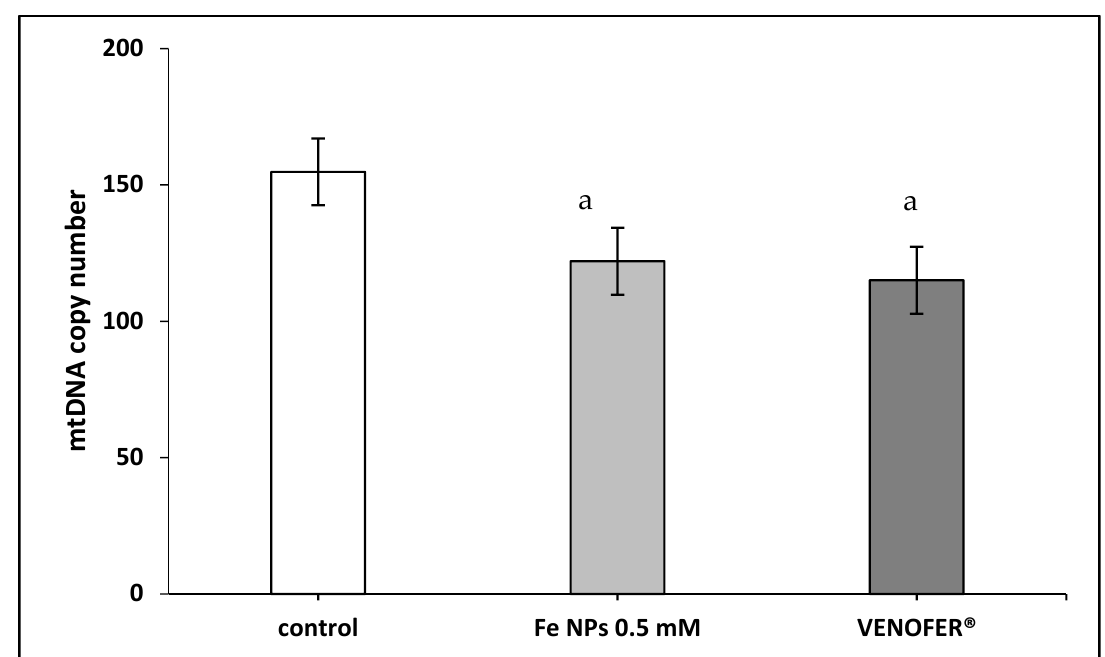
Figure 2. ND1/ND4 mtDNA deletion. Results expressed as mean ± SEM. ( p < 0.05). (a) vs. control ( p < 0.05).